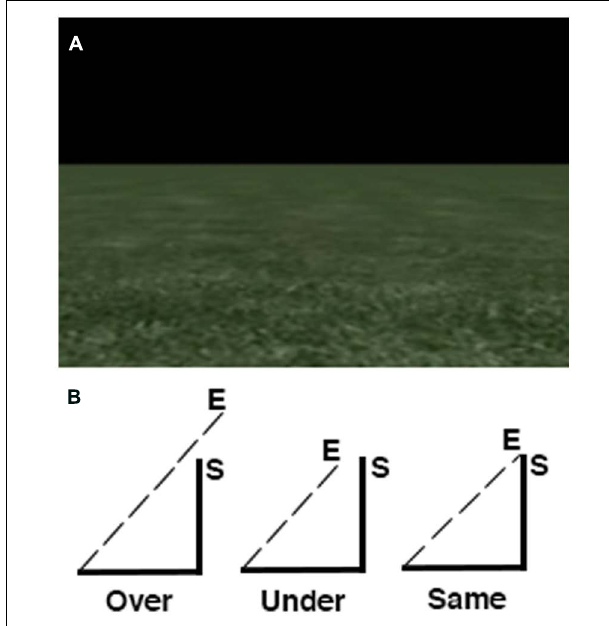
FIGURE 1 | Overview of the path integration task. (A) Screen display depicting the textured ground with a horizon and black sky. (B) Distance estimations were always in relation to the last edge of the